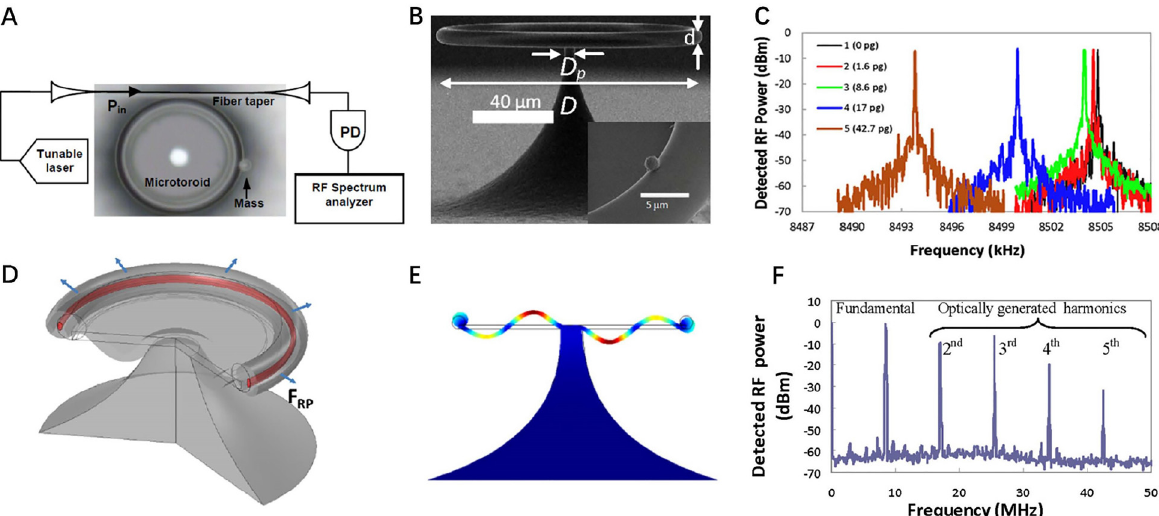
Figure 9: (A) Sketch of experimental setups for mass measurement using microtoroid optomechanical systems. (B) Scanning electron microscope (SEM) image of one of the utilized microtoroids. Inset: a polyethylene microbead landed on the toroidal region of the resonator. (C) Radio frequency (RF) spectrum near the fundamental frequency as adding microbeads with different mass. (D) Schematic diagram of radial breathing mode of microtoroids. (E) Finite-element simulation of modeling for displacements of one of the mechanical modes. (F) RF spectrum of the optical output power in the absence of the microbeads